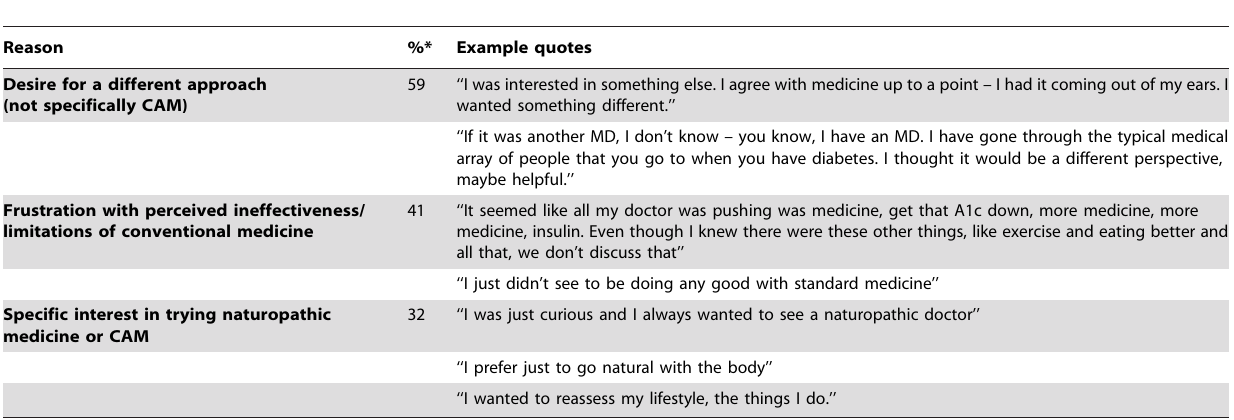
Theme 1: Patient Centered. Various aspects of the patient- centeredness of the interaction, a major focus of CAM and integrative medicine [23,24], were noted by 95% of participants. Table 2. Reasons people with diabetes chose to participate in a study of naturopathic care (n=22).